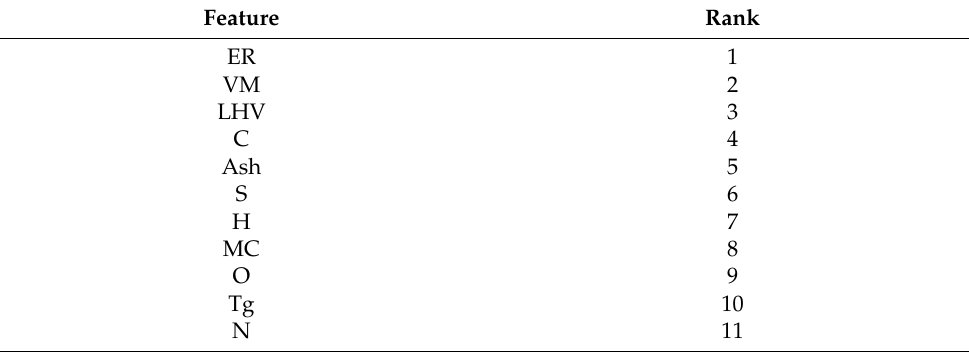
Table 1. Feature importance rank of the H 2 model.